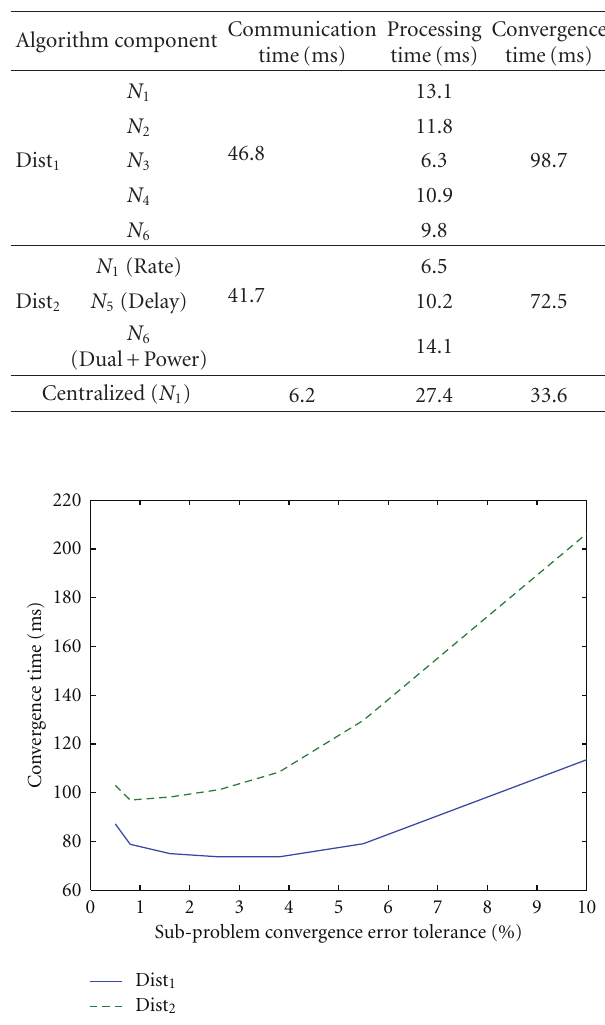
Table 1: Overall convergence time components.